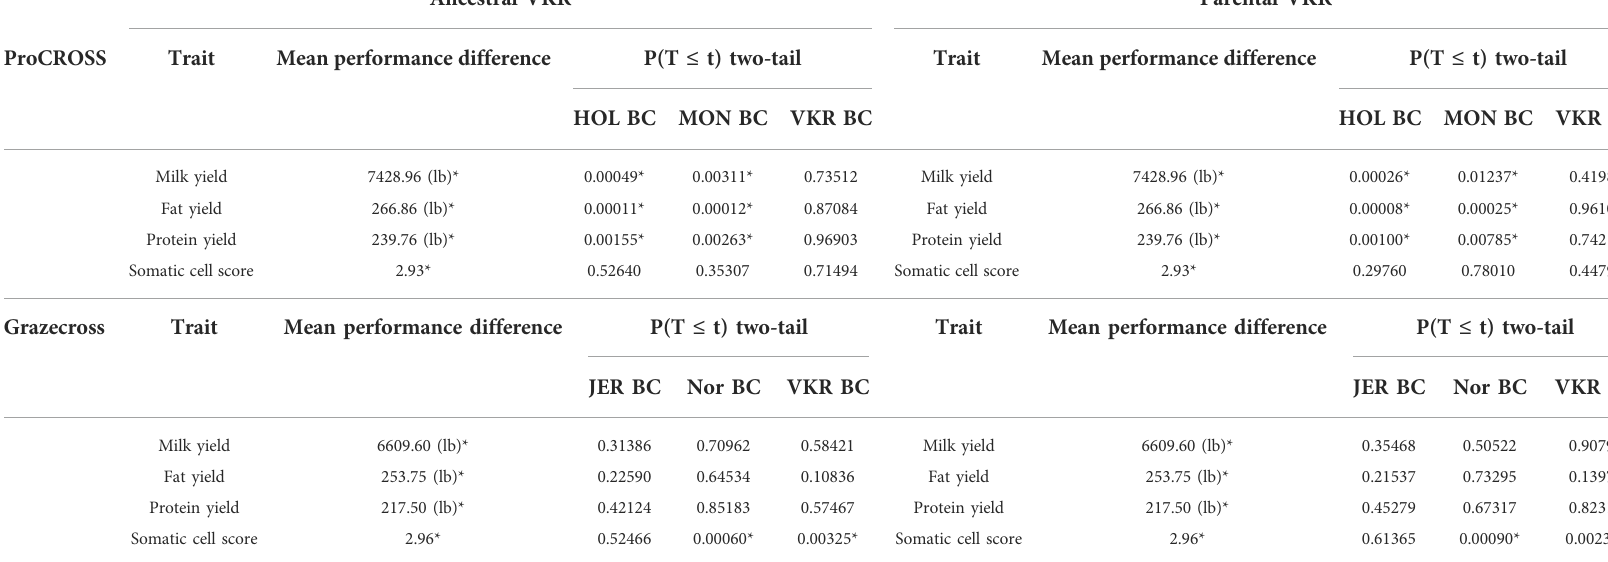
Signi fi cant difference with p -value <